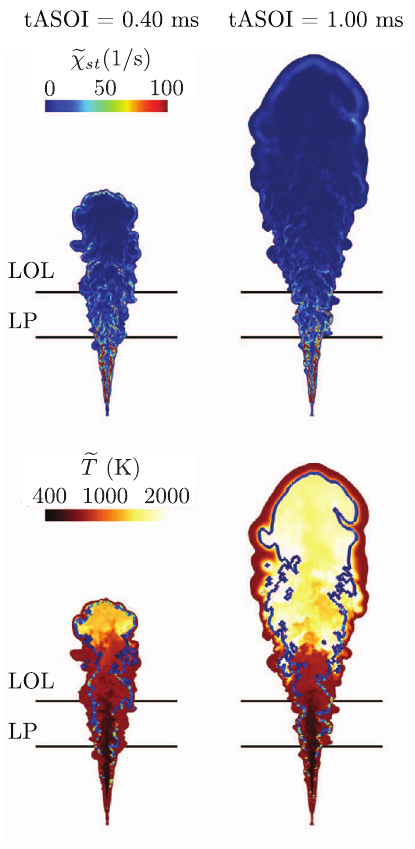
Fig. 9. Distribution of the scalar dissipation rates at stoichiom- etry ~ v st used for table look-up (top row) and temperature ~ T overlaid with the iso-line of ~ Z ¼ ~ Z ~ v st colored according to the st (bottom row) for 0.40 ms (left column) and 1.00 ms ASOI (right column). The black horizontal lines denote the experimentally obtained liquid penetration LP of 9.6 mm [60] and the steady Fig. 12. Evolution of the maximum temperature ~ T max (solid ~ lift-off length LOL of 16.1 mm [56], respectively. Y OH ; max (dashed lines) during the lines) and OH mass fraction simulation of the ECN Spray A for the UFPV (black lines) and RUFPV approach (blue